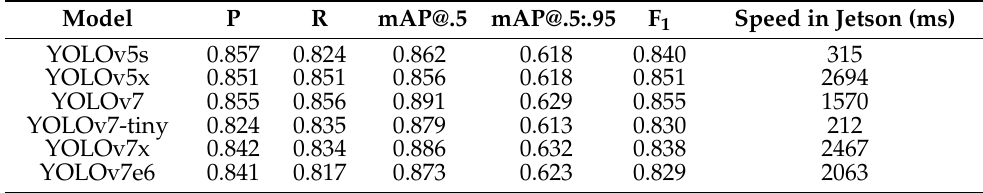
Table 6. Performance of different detection